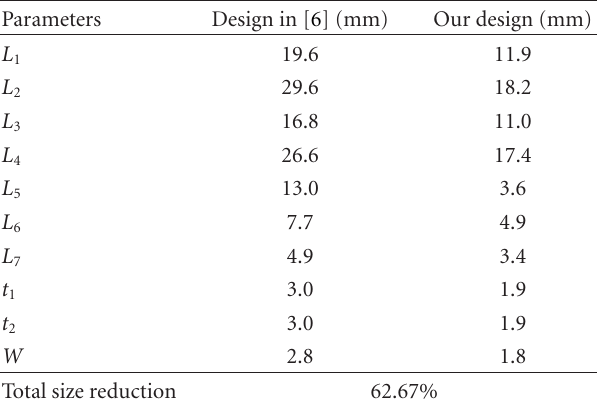
Table 1: Design parameters of embedded spiral-shaped microstrip implantable